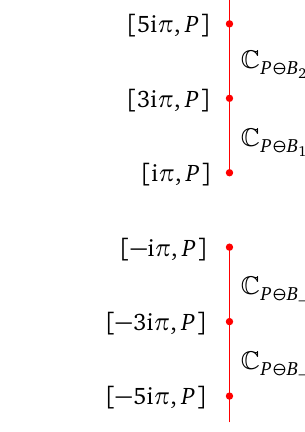
Figure 12: Choice of branch cuts (red, vertical lines) partitioning the Riemann surface R into the sheets (cid:67) , P (cid:64) (cid:90) + 1 / 2. The ramification points of the covering map Π P from R to the infinite cylinder C are represented with red dots. The connectivity of the sheets is indicated near the cuts, with B defined in (35) and (cid:9) the symmetric n difference operator from